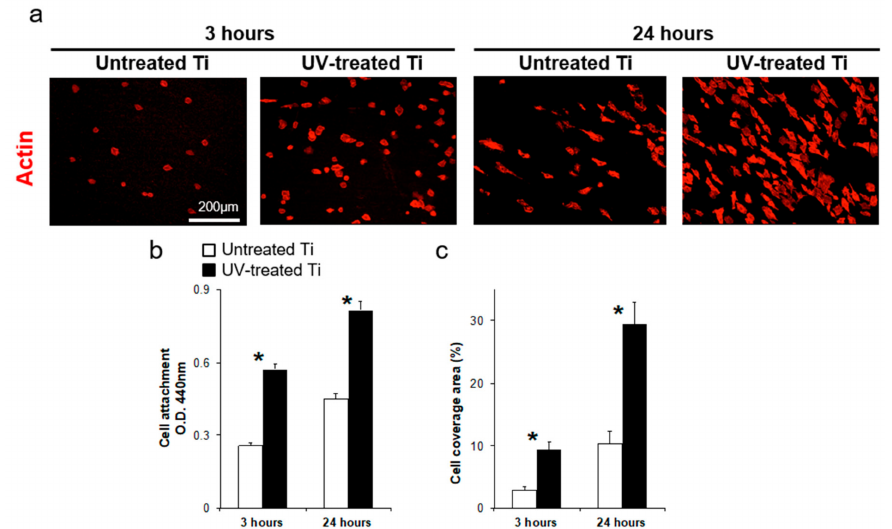
Figure 2. Initial cell attachment of human oral epithelial cells cultured on untreated control and UV-treated titanium surfaces. ( a ) Cells cultured on the untreated control and UV-treated titanium surfaces were stained for actin with rhodamine- phalloidin (red) and observed by using fluorescence microscope after 3 and 24 h of culture. Scale bar = 200 µ m. ( b ) Cell number was quantified with a colorimetric-based WST-1 assay (* p < 0.05). ( c ) Cell coverage area as a percentage on the untreated control and UV-treated titanium surfaces (* p < 0.05).